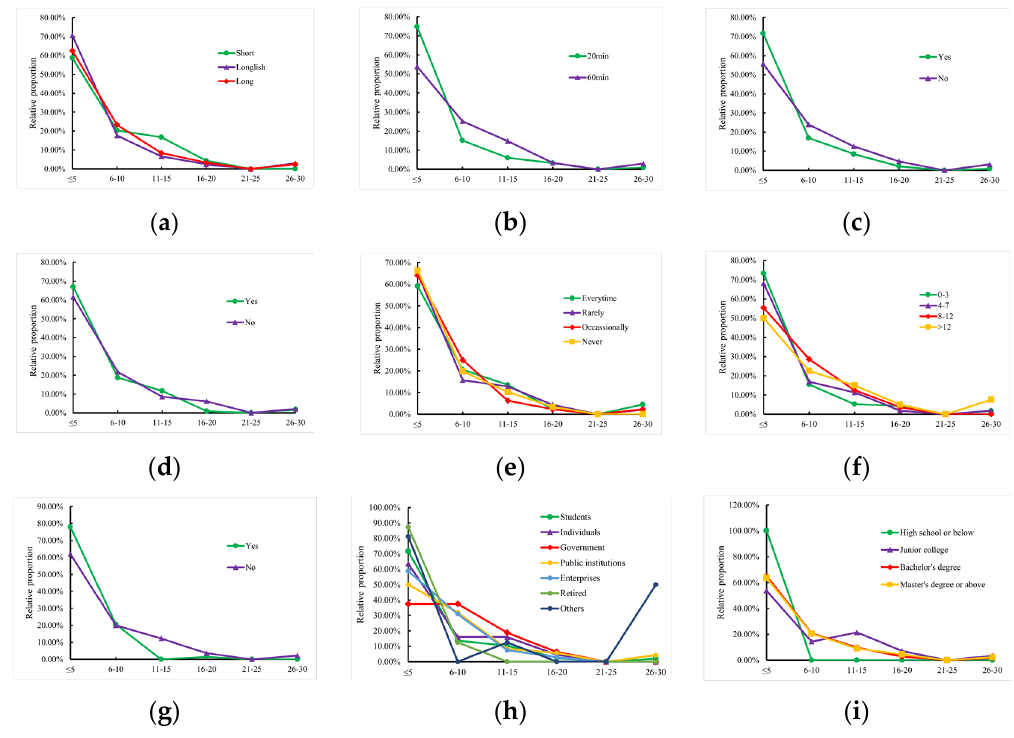
Figure 1. Line chart of the waiting time distribution for the different attributes (( a ). service interrup- tion (SI) duration; ( b ). travel distance; ( c ). bus bridging; ( d ). information accuracy; ( e ). information usage; ( f ). travel frequency; ( g ). SI experience; ( h ). occupation; ( i ). education level). Table 6. Descriptive statistics of socio-demographic